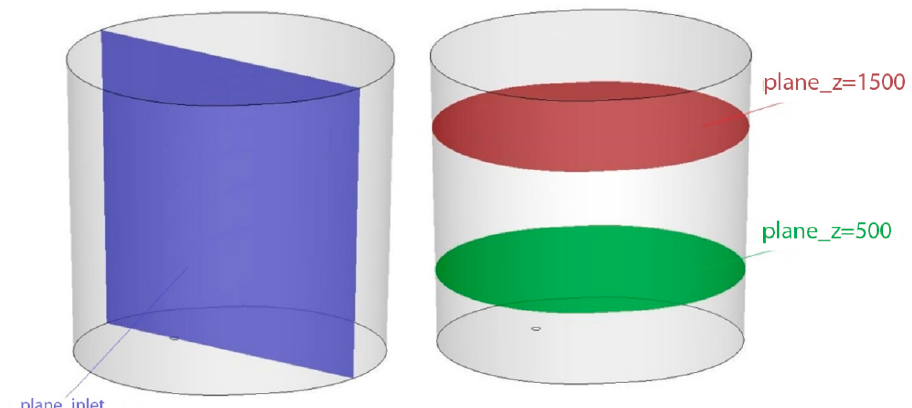
Figure 2. Control planes in the ladle to simulate the movement of the metal bath.